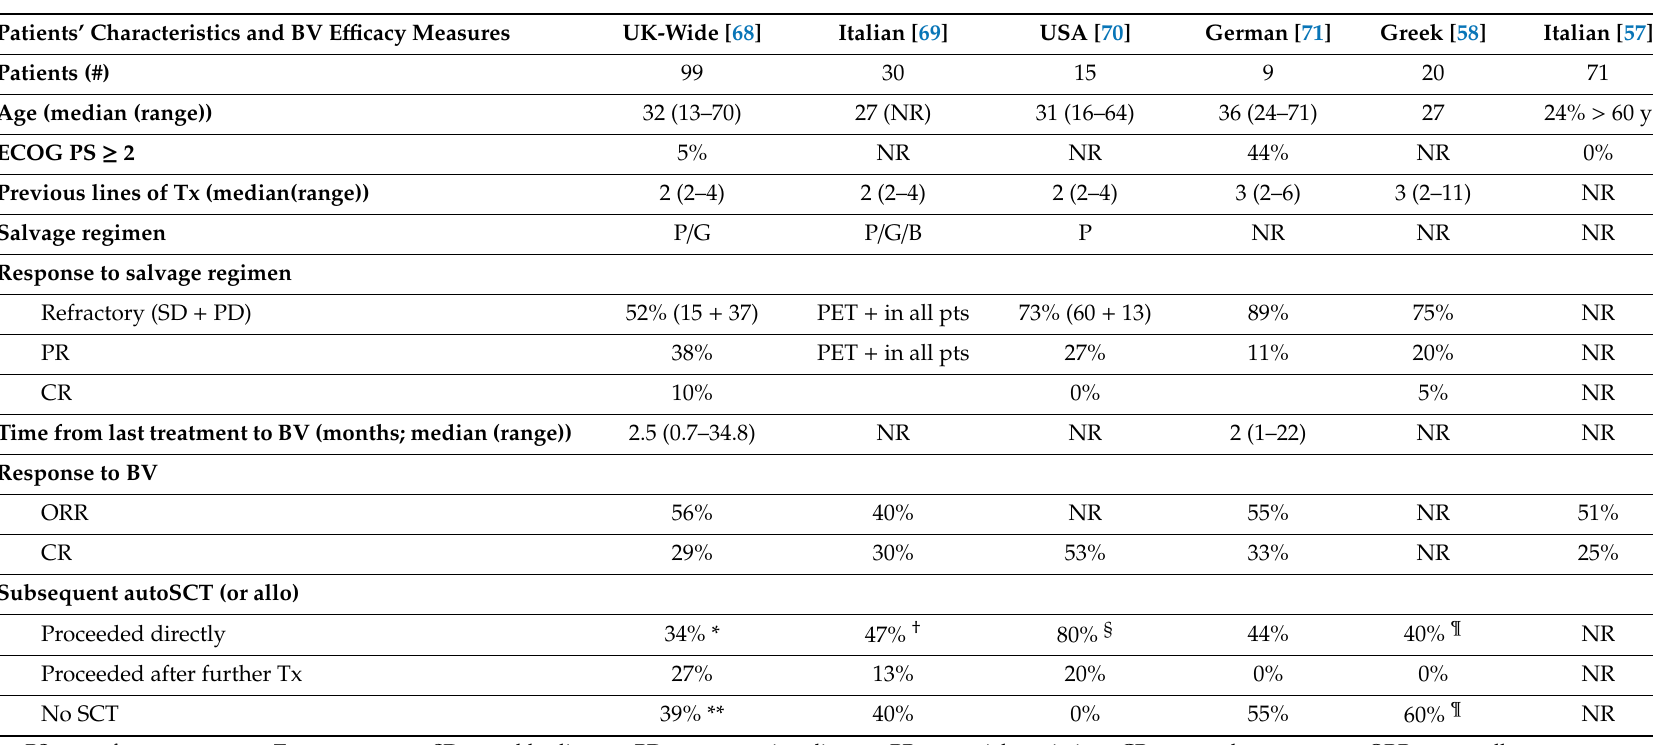
Table 2. Summary of studies of brentuximab vedotin in chemorefractory, transplant-ineligible patients with relapsed / refractory classical Hodgkin lymphoma. Patients’ Characteristics and BV E ffi cacy